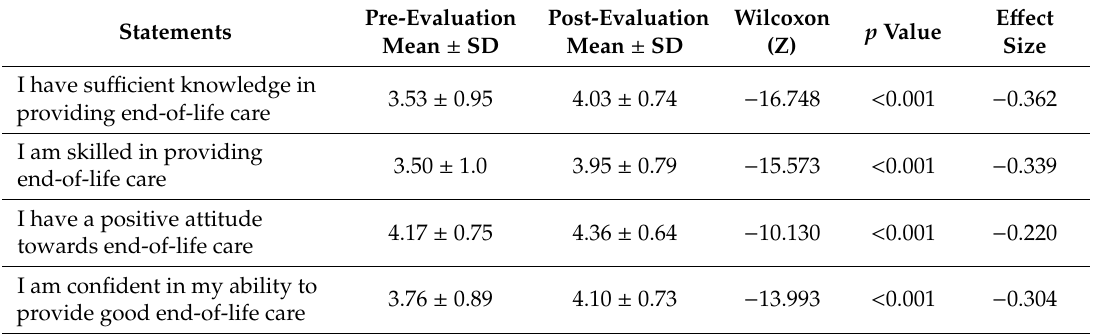
Table 1. Learners’ knowledge, skill, attitude, and confidence in providing end-of-life care to patients living with chronic complex illness.